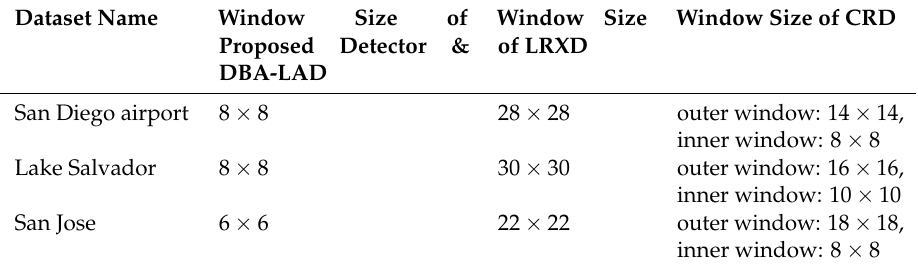
Table 2. Window size for different detectors in different dataset after optimization.